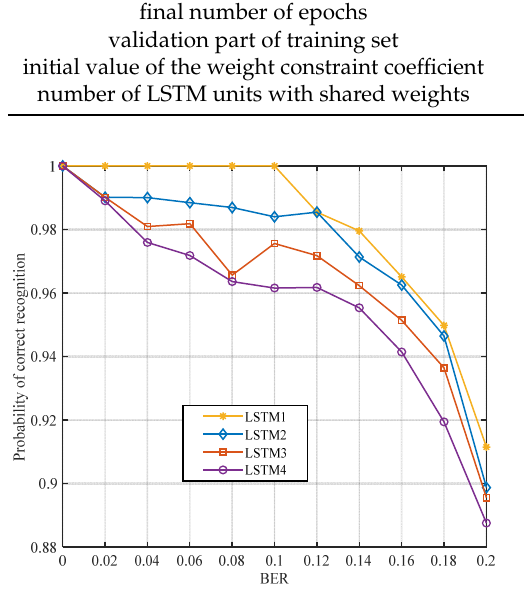
Figure 7. Effect of the number of LSTM layers on the performance of the algorithm.